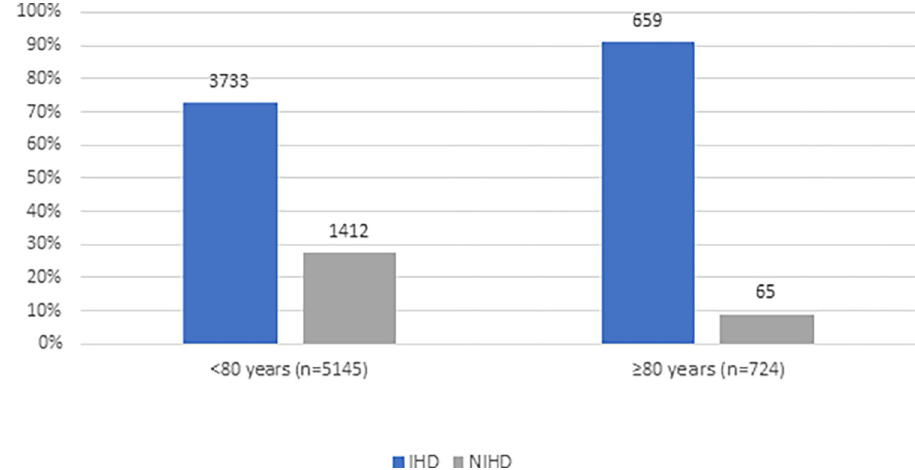
Fig 2. The proportion of ischemic heart disease (IHD) and nonischemic heart disease (NIHD) as a cause of sudden cardiac death (SCD) in < 80 years old and � 80 years old. IHD was more commonly cause of SCD in � 80 years old than < 80 years old (91.0% vs. 72.6%, P < .001). Percentages represent a proportion of cause of SCD in each age group seperately. Values over the bars represent the number of cases in the age